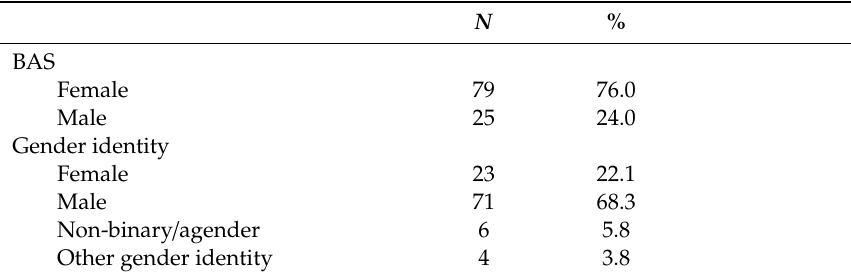
Table 1. Sample demographics, autistic traits, psychopathology and quality of